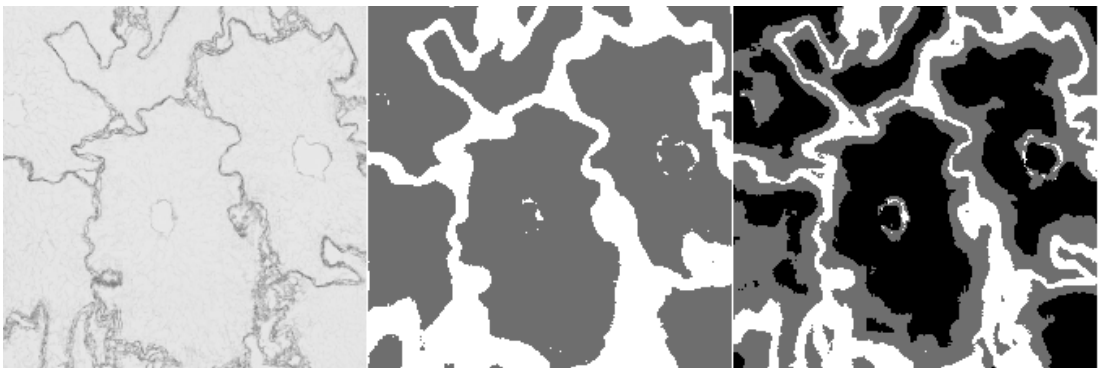
Figure 8. Example of semantic segmentation, where the neural network reached worse results. The original image (on the left ), the result from the HCTFS (in the middle ), and the results from the neural network (on the right ).